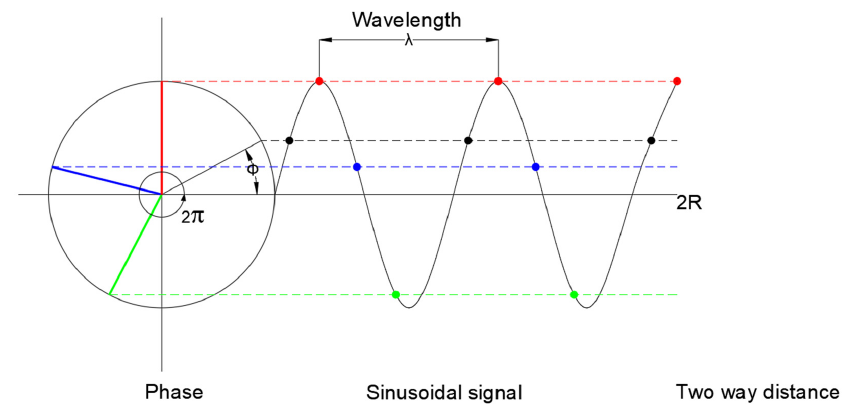
Figure 3. Phase difference. Source: ESA-TM19 InSAR Principles.